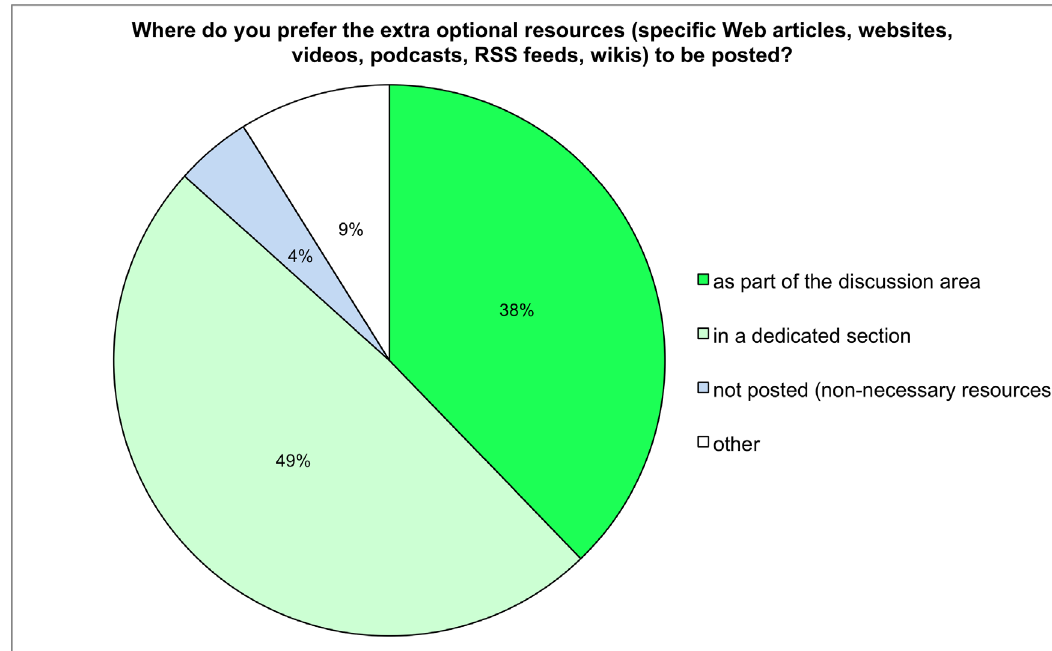
Figure 7 . Student preference for extra resource location.